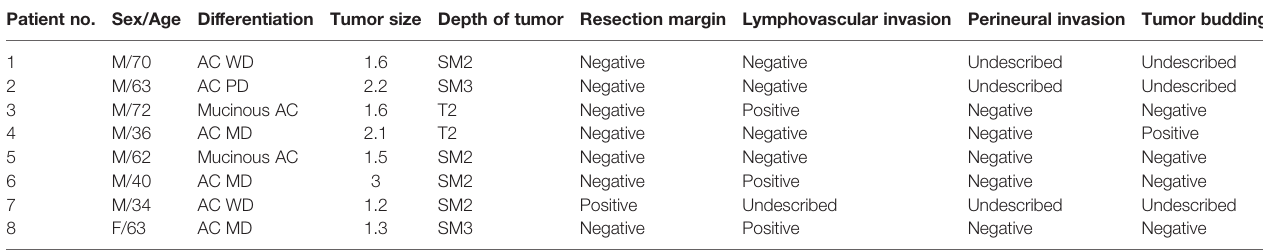
TABLE 2 | Histopathologic characteristics of patients with local recurrence after local excision with adjuvant